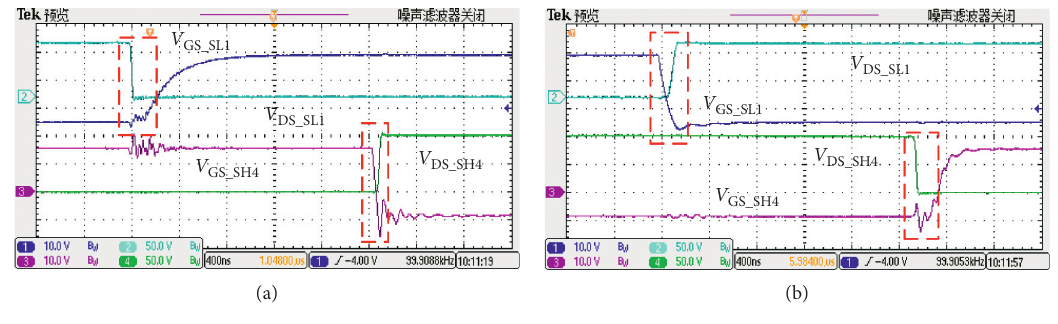
Figure 15: ZVS waveforms at half